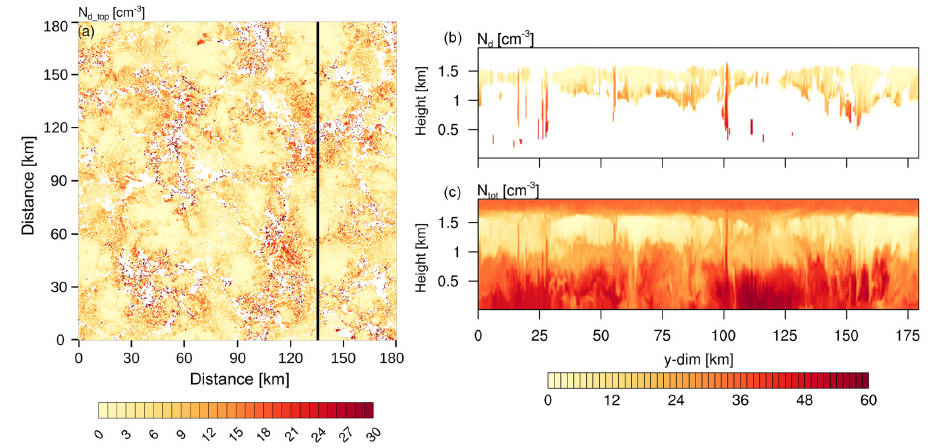
Figure 2. (a) Instantaneous cloud-top droplet number concentration, N d_top (corresponding snapshot to LWP field shown in Fig. 1d). The black line denotes the location of the cross section of (b) cloud droplet number concentration ( N d ) and (c) total number concentration ( N tot = N a + N d , where N a denotes the aerosol number concentration). Cloud top is defined as in Table